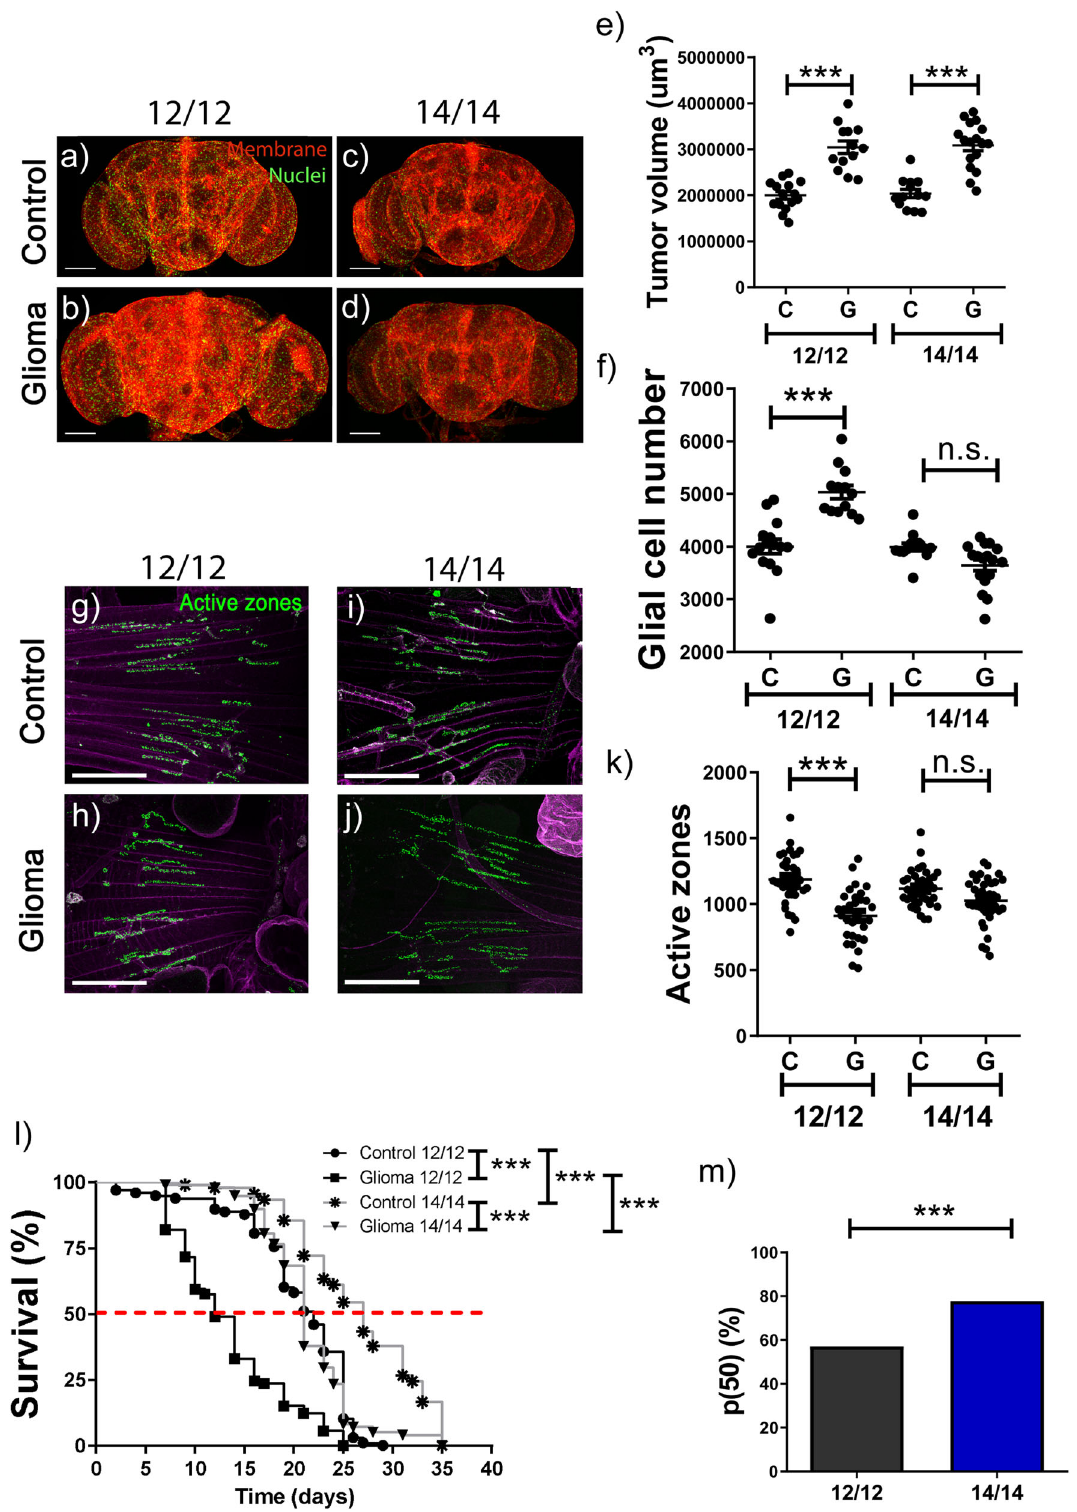
(thus increasing synapse number) in such PDFn rescued morning anticipation, a speci fi c circadian response, despite it was not able external cues to a longer L:D period effectively rescued GB- associated phenotypes, even after the GB